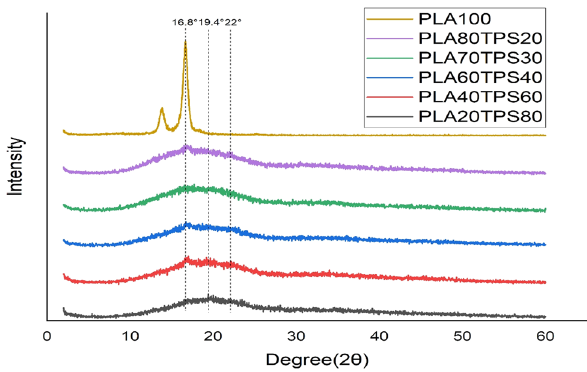
Figure 2: The XRD patterns of neat PLA and PLA/TPS